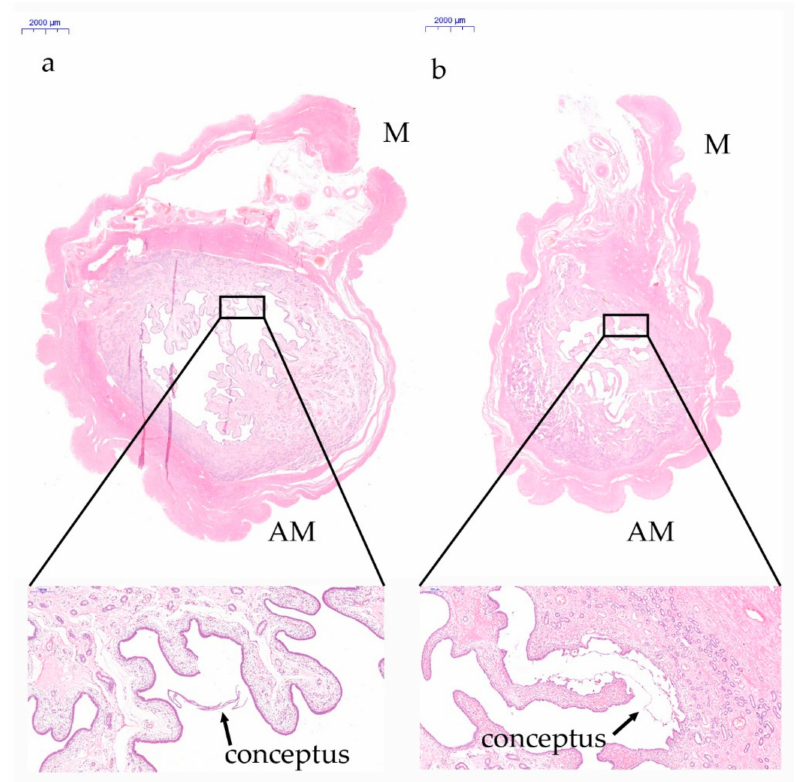
Figure 1. Photomicrographs of representative uterine sections obtained from gestational days 12 and 15 in pigs and stained with hematoxylin and eosin. ( a ) On gestational day 12, the filamentous conceptus migrates toward the mesometrial side of the uterus. ( b ) On gestational day 15, the conceptus attaches at the mesometrial side of uterus. M, mesometrial side of uterus. AM, anti-mesometrial side of uterus. 3.2. Gene Expression Patterns before and after Conceptus Attachment Di ff ered between the Mesometrial and Anti-Mesometrial Endometrium in the